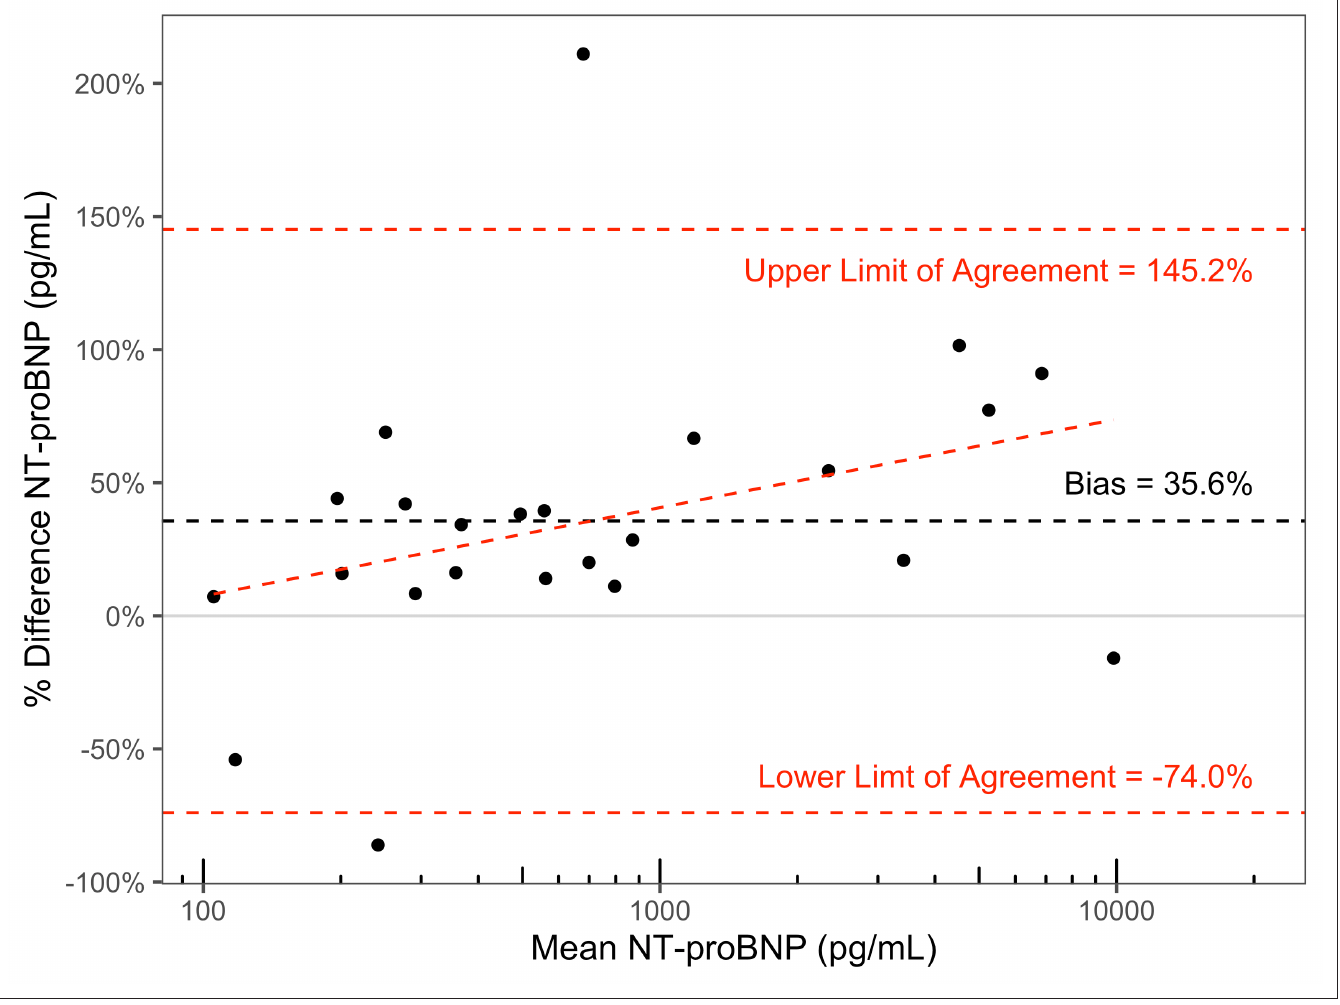
Figure 4 Bland–Altman plot of point -of- care (POC) and laboratory N- terminal B- type natriuretic peptide (NT- proBNP), with the mean of the laboratory and POC readings on the x - axis, and the percentage difference on the y - axis (calculated as POC – Laboratory / Laboratory). POC readings are 35.6% higher on average than paired laboratory readings (95% confidence interval (CI) = 12.0 to 59.2%). Upper and lower limits of agreement are 145.2% and –74.0%